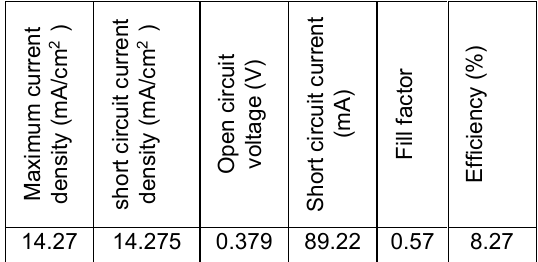
Table 7. Performance parameters of sample C